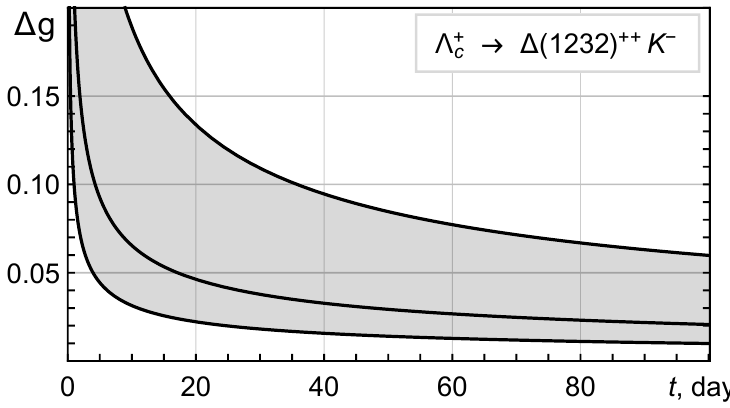
Figure 10 . Error of the gyromagnetic factor g as a function of data taking time t for the (cid:1) ++ (1232) K (cid:0) decay